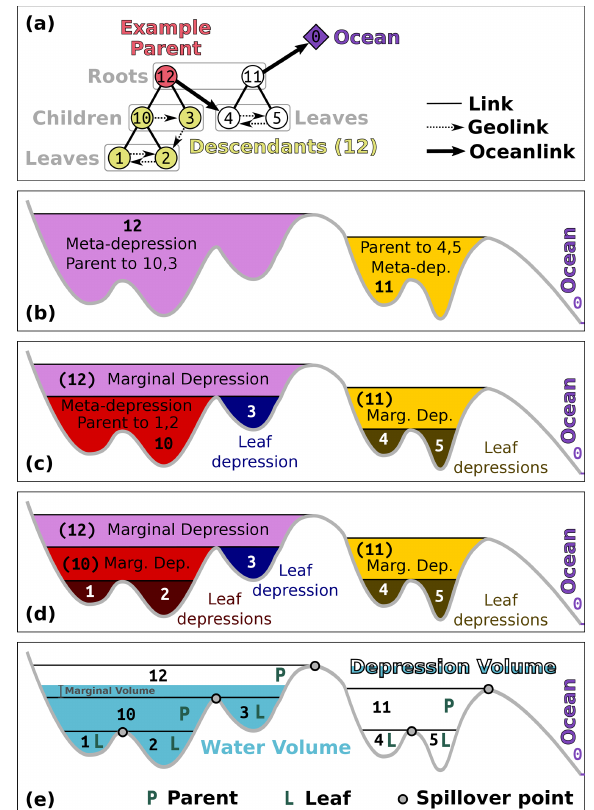
Figure 2. Terminology for the depression hierarchy and water flow through it. The depression hierarchy shown here is drawn from the left-hand side of Fig. 1 from the companion paper by Barnes et al. (2020). (a) Topology. A parent and its descendants are asso- ciated with depressions (b–d) . Direct descendants are called chil- dren . Leaves are the terminal members of the depression hierar- chy; they have no children and represent simple depressions (i.e., those that are not meta-depressions). Members of a single binary tree are joined in their hierarchy through links ; directional links that represent water-spillover directions between geospatially adjacent depressions are called geolinks . Flow from one binary tree into an- other and towards the ocean follows the oceanlinks . Though only one binary tree is shown, the ocean may be the parent to an arbi- trarily large forest of binary trees. (b) Parents in the hierarchy form meta-depressions – depressions that encompass other